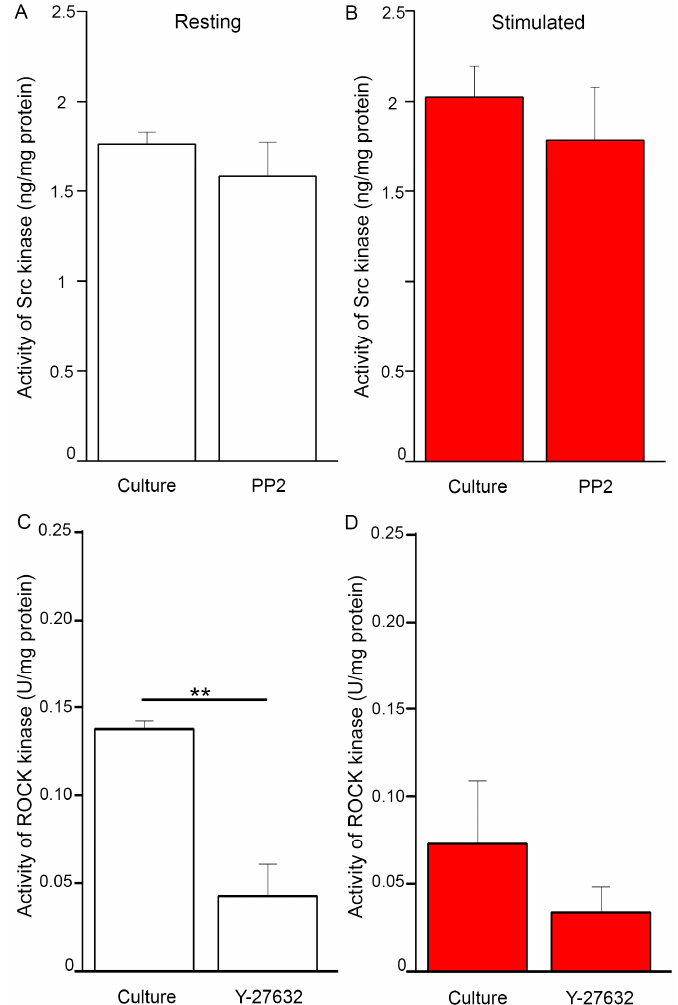
Figure 8. ( A , B ) The activity of Src kinase in Saos-2 cells, non-treated or treated with inhibitors, in resting conditions ( A ) or after stimulation with AA and β -GP ( B ). The activity was measured by a STAR Src ELISA Kit (Upstate-Millipore-Sigma, Saint Louis, MO, USA) using a SpectraMax M5e reader (Molecular Devices), Ab = λ 450 nm, ( n = 4). ( C , D ) The activity of ROCK kinase in Saos-2 cells, non-treated or treated with inhibitors, in resting conditions ( C ) or after stimulation with AA and β -GP ( D ). The activity was measured with ATP, without ATP (negative control), or with ATP and Y-27623 together (positive control) by a CycLex Rho-kinase Assay Kit (CycLex Co., Ltd., Nagano, Japan) using a SpectraMax M5e reader (Molecular Devices), Ab = λ 450 / 540 nm, results were calculated as a di ff erence between data obtained with ATP versus data obtained with ATP and Y-27632 together ( n = 3), ** p <